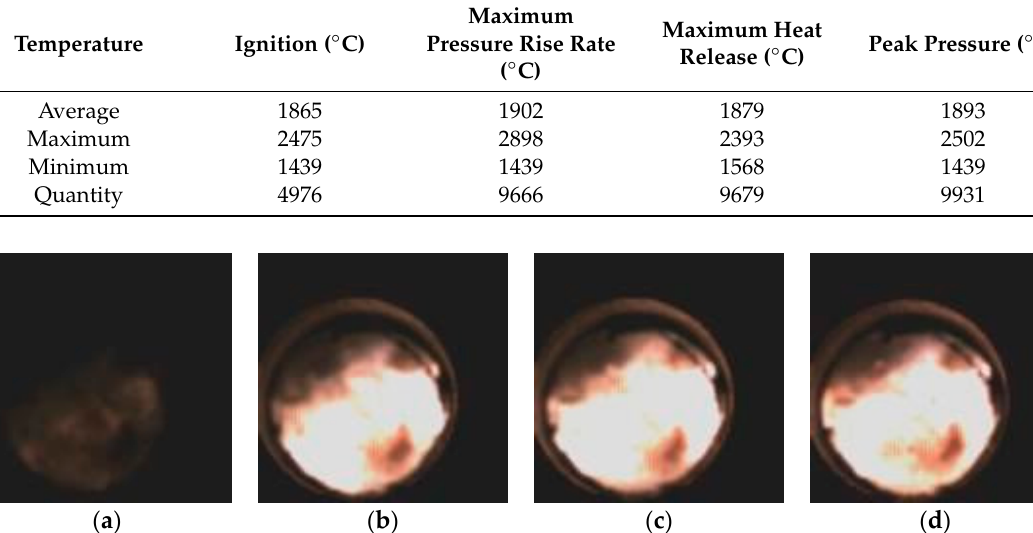
Figure 5. Calculated temperature field image of series 2 with MATLAB. ( a ) Ignition moment; ( b ) maximum pressure rise rate; ( c ) maximum heat release; ( d ) the highest pressure. Table 2. Typical temperature of series2 with MATLAB.